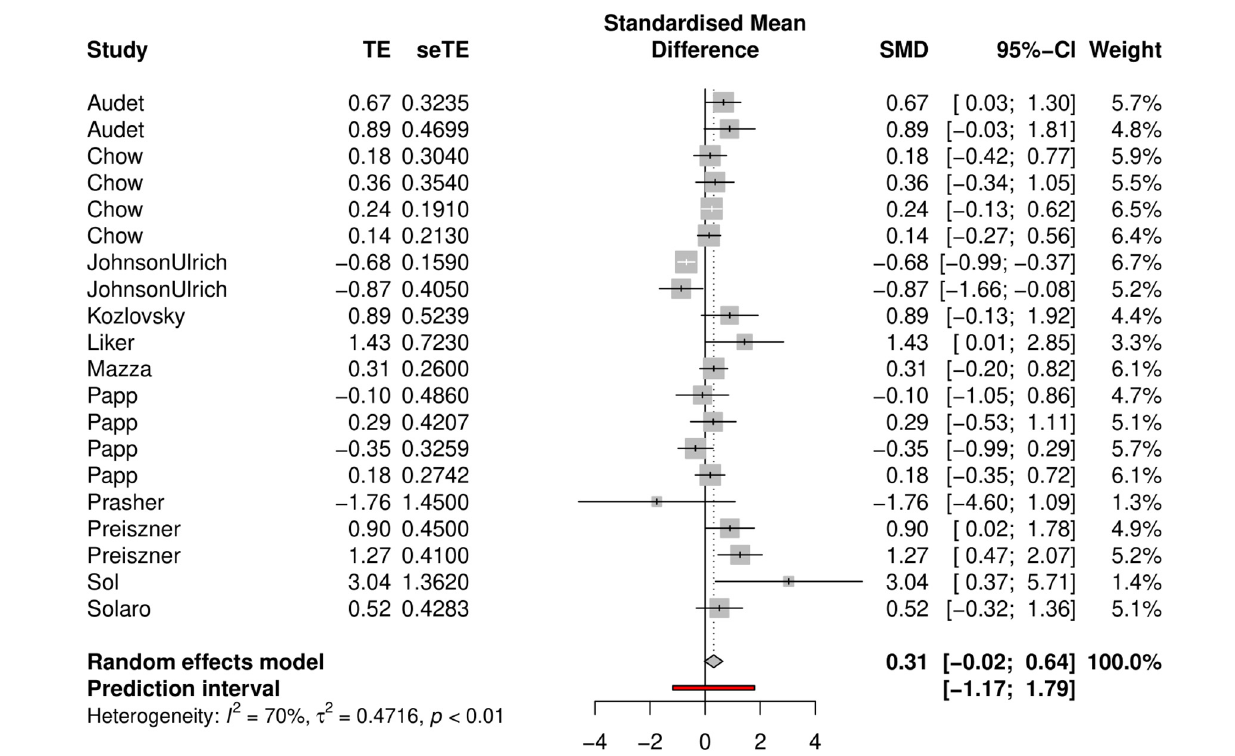
FIGURE 3 | Forest plot showing effect sizes ( Z values from Cox models or T values from linear models, indicating the differences in problem-solving latency between urban and rural animals) with 95% confidence intervals. Positive values indicate that animals from urban environments were faster problem-solvers whereas negative values indicate that animals from rural populations solved